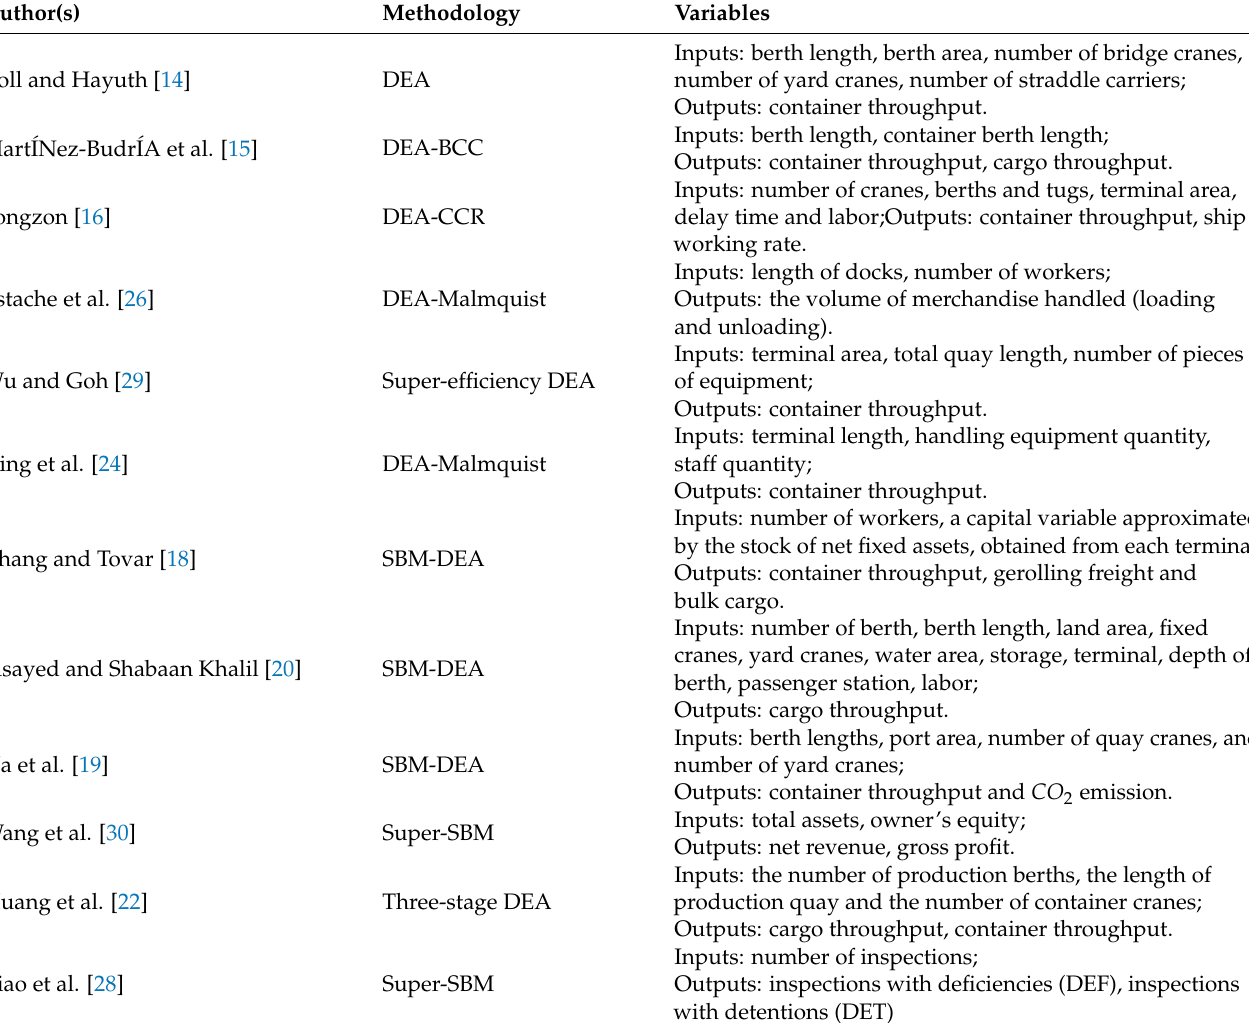
Table 2. Summary of DEA models used in port